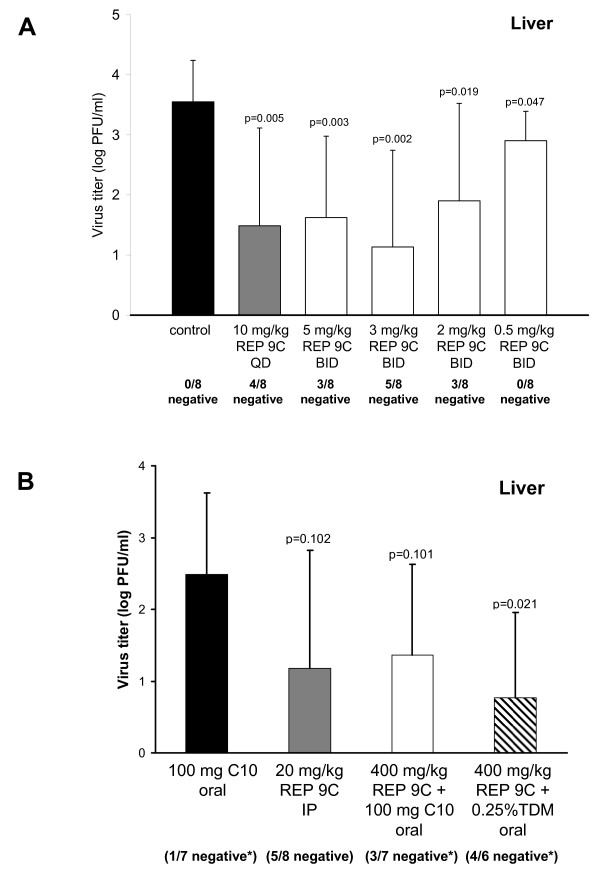
In vivo Antiviral Dose Effect of REP 9C following Intraperitoneal or Oral Dosing. (a) Virus titer levels in the livers from mice treated with various doses of REP 9C. Three-week old mice (8 mice/group) were treated by daily i.p. administration of saline or 10 mg/kg (QD), 5 mg/kg (BID), 3 mg/kg (BID), 2 mg/kg (BID), or 0.5 mg/kg (BID) of REP 9C starting at 8 days prior to infection with MCMV and continued for 11 days. Data represents results from one of two separate experiments; Mean +/- standard deviation (n = 8). (b) Virus titer levels in the livers from mice treated orally with 100 mg sodium caprate (C10), 20 mg/kg REP 9C, 400 mg/kg REP 9C in 100 mg C10, and 400 mg/kg REP 9C in 0.25% (w/v) TDM. Five-week old mice (8 mice/group) were treated by daily oral administration of C10 or REP 9C + C10 or TDM starting 2 days prior to i.p. inoculation with 1 × 105 pfu of MCMV (K181+) and continued to 3 days post infection. Data represents results from one of two separate experiments with similar outcomes; mean +/- standard error (n = 8). The asterisk indicates groups in which mice died due to non-drug related technical difficulties with oral administration. In (a) and (b), mice with no detectable MCMV titer are indicated as x negative/8 total below each bar. P values are shown in figure.